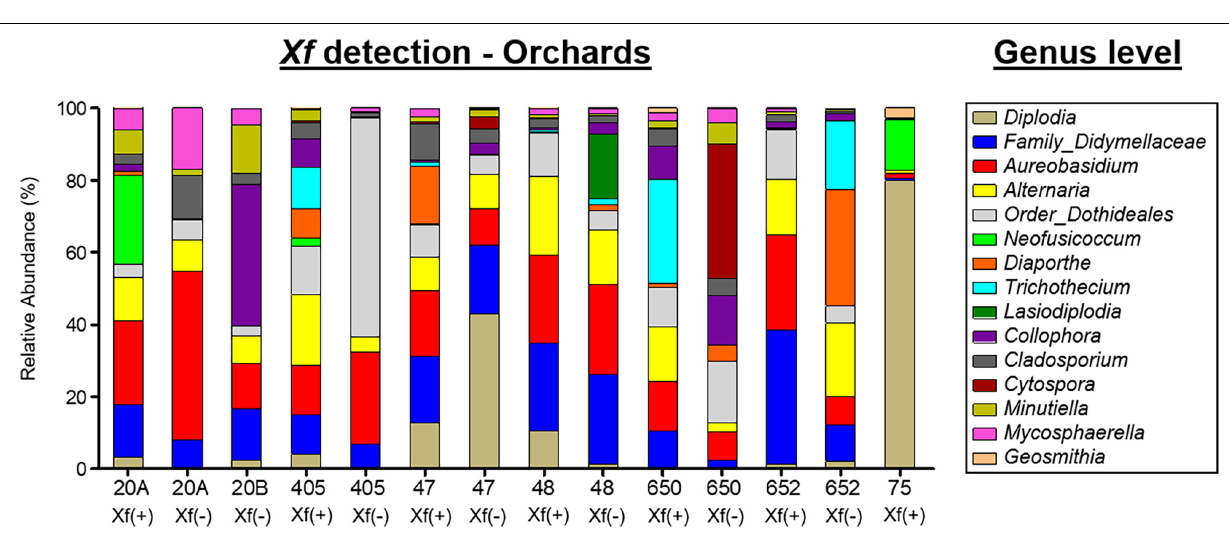
Frontiers in Microbiology |